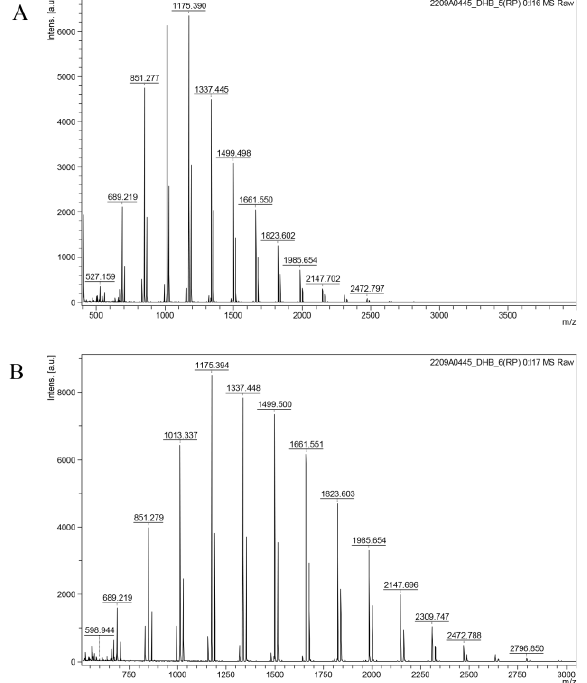
Figure 3. ( A ) MALDI-TOF-MS spectrum of cMORP in the range of 400–4000 m/z; ( B ) MALDI-TOF- MS spectrum of cMORP in the range of 500–3000 m/z.